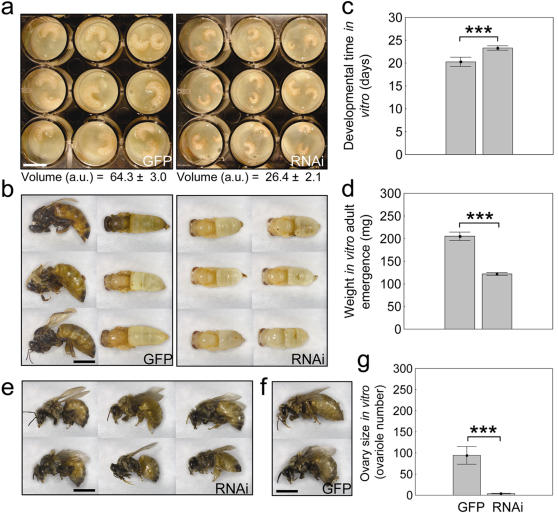
Effect of amTOR suppression on caste characters in honey bees.In comparison to control (GFP), amTOR RNAi (RNAi): a, reduced larval growth (exemplified by 4-day-old larvae in sections of a microtiter plate, larval volume is mean±s. e. arbitrary units a.u.); delayed development, b–c, where b is a snapshot of the full phenotypic variance in each group (individuals were 19 days old) – controls emerged with queen morphology, or had advanced pigmentation (indicates more rapid development) and large size. RNAi bees were lightly pigmented and small in size; the latter effect is shown also in d, the wet-weight at adult emergence and in e, the final adult size. Adult size did not overlap between treatment groups (e vs. f, where f shows the two control bees with lowest wet-weight: 155 and 161 mg; weight-range after RNAi was 108–136 mg). amTOR RNAi also reduced ovary size g, to ovariole numbers characteristic of workers (GFP range was 12–180, RNAi range was 2–7 ovarioles per ovary). In sum, the divergence between control and amTOR RNAi is characteristic of queen vs. worker development [5]. Bars are means±s. e. (three asterisks P<1.0 10−3). Scale bars a: 10 mm; b, e, f: 5 mm.